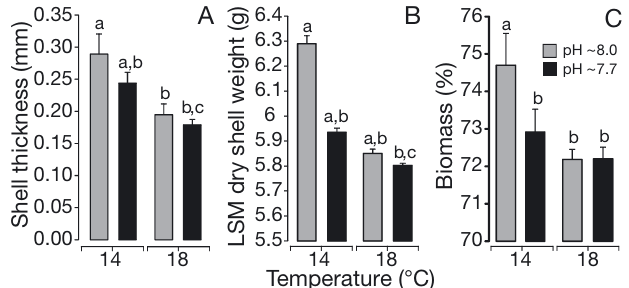
Fig. 3 . Mean ± SE (A) shell thickness, (B) dry shell weight, and (C) wet biomass of Argopecten purpuratus reared at Fig. 4. Growth rates measured as increments in the shell nominal pH levels in seawater and at 2 temperatures. All height and length (mean ± SE) of Argopecten purpuratus measurements were recorded at the end of the study period individuals reared at 2 temperatures and 2 nominal pH (18 d). LSM: least square mean, which corresponds to the levels in seawater. These rates were estimated based on the predicted value of dry shell weight at the mean value of difference between initial and final measurements after the buoyant weight, used as covariate in an ANCOVA model 18 d experimental period. Different letters indicate signifi- (see ‘Materials and methods’). Different letters indicate sig- cant differences among treatments (n = 5) using a post hoc nificant differences among treatments (n = 5) using a post Tukey HSD hoc Tukey HSD test